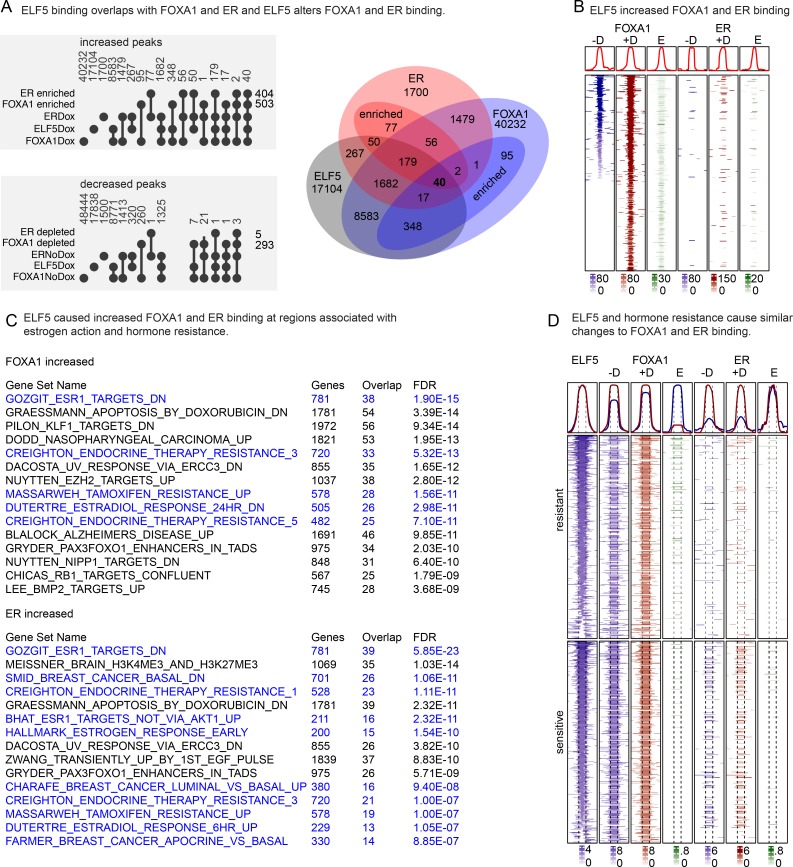
Induction of ELF5 alters FOXA1 and ER binding to the genome.Panel A, UpSet presentation of DiffBind output that identified statistically significant increases in FOXA1 or ER binding in response to induction of ELF5 with doxycycline (Dox). Corresponding Venn diagram for increased (enriched) peaks is shown. Lower panel, decreased peaks. Panel B, FOXA1 peaks that were increased by induction of ELF5 (+D, red) are plotted, centred on the FOXA1 peak, with the corresponding binding of FOXA1 at that location without induction of ELF5 (-D, blue). The resulting differential binding is shown in green. The binding of ER at these FOXA1 sites is shown with (+D, red), and without (-D, blue), with differential binding in green. Histograms show cumulative intensity on the y axis over the corresponding genomic region on the x axis. Color scale denotes log 10 of MACS (-D and +D columns) or DiffBind scores (E columns). Panel C, GREAT analysis of binding site function for increased binding sites for FOXA1 and ER. Blue indicates sets involved in estrogen action. Panel D, FOXA1 and ER binding sites that are specific in MCF-7 cells that were either sensitive to, or made resistant to, endocrine therapy, with corresponding ELF5 binding intensity. Histograms compare overall intensity with (+D) and without (-D) induction of ELF5 and green shows the enrichment (E) in response to ELF5. Color scale denotes log 10 of MACS (-D and +D columns) or DiffBind scores (E columns).